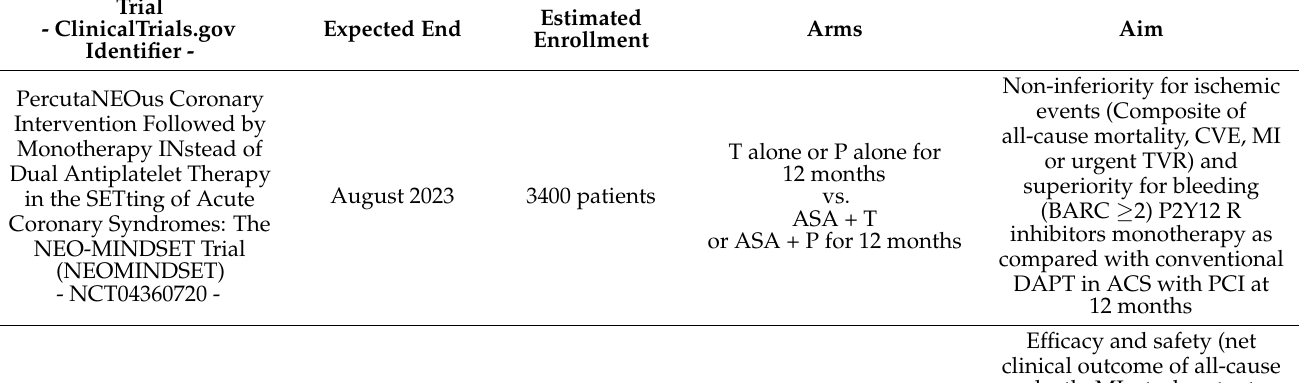
Table 3. Principal clinical ongoing trials on antithrombotic therapy for CAD patients with history of CVE. Trial -